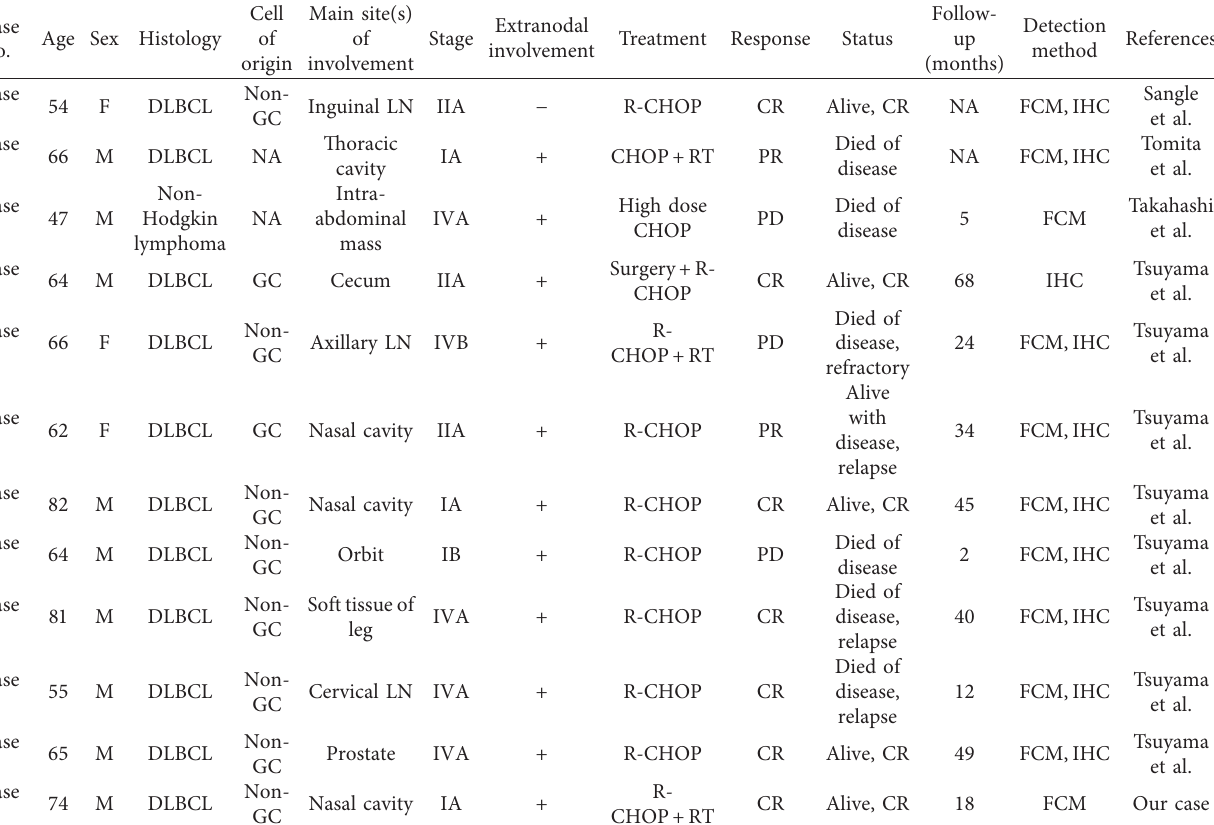
Table 1: Clinical characteristics of CD7-positive B-cell